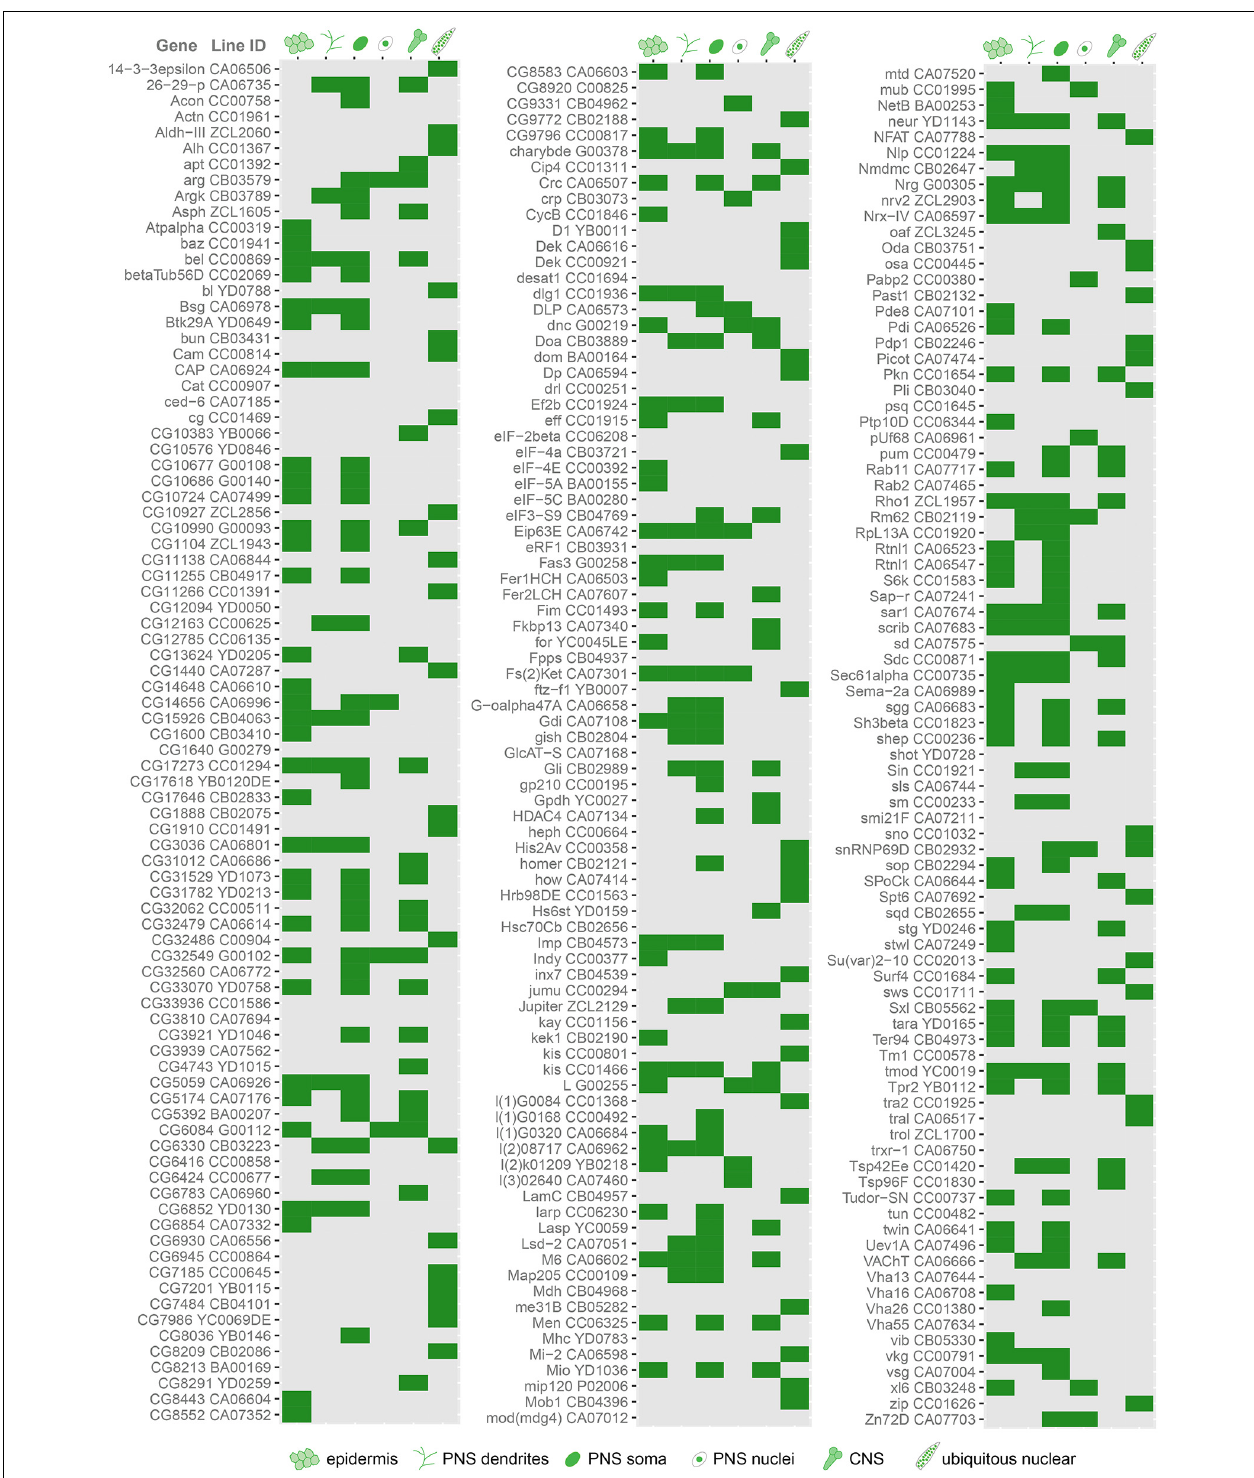
FIGURE 1 | Cell type-specific protein expression and localization patterns in da neurons revealed by screen of protein trap lines. Chart showing the results of a screen of protein trap lines. Green indicates that GFP expression was observed, while gray indicates absence of detectable GFP signal by epifluorescence microscopy. Line ID refers to names assigned by creators of the lines, and the gene associated with each line is based on insertion site of the GFP-coding exon. Some lines exhibit ubiquitous nuclear GFP expression, which may be due to enhancer trapping and may not reflect true expression pattern of the associated gene (see